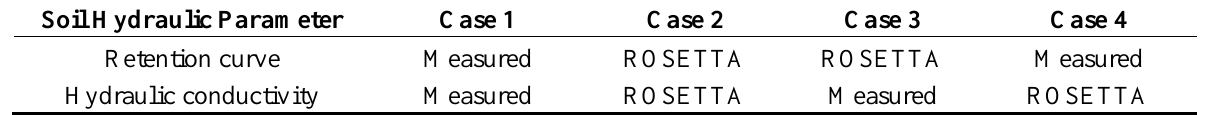
Table 3. Combinations of parameters input to